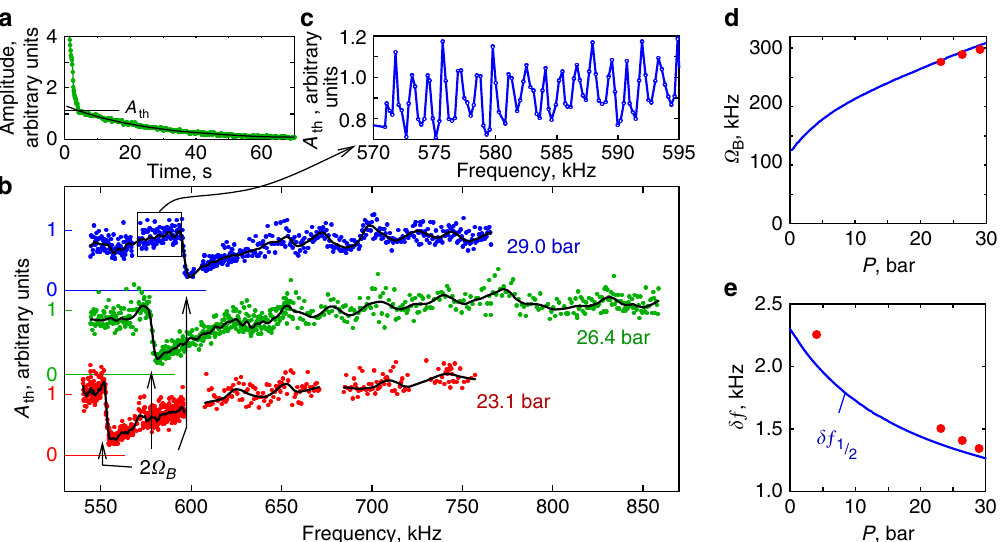
Figure 3 | Measurements of the Suhl instability. ( a ) An example measurement of the NMR signal amplitude during the magnon condensate decay obtained at o L /2 p ¼ 741kHz and P ¼ 26.4 bar. A Suhl instability threshold at the amplitude A th is clearly seen. ( b ) Dependence of the threshold amplitude A th on the frequency of optical magnons o opt E o L (coloured symbols) for three pressures P . Sharp decrease is seen at o opt ¼ 2 O B ( P ), where the decay of an optical magnon to two light Higgs bosons becomes possible. Black lines are smoothed data using running average. Curves for different pressures are shifted in the vertical direction and respective zero levels are marked by horizontal lines. ( c ) Zoom to one measurement in ( b ) shows periodic modulation, which corresponds to resonances of acoustic magnons in the experimental container. ( d ) Pressure dependence of the light Higgs boson mass O B (symbols) from measurements in ( b ). ( e ) Frequency separation of acoustic magnon resonances (symbols) from measurements like in ( c ). Solid lines in ( d , e ) are theoretical values based on known 3 He parameters 28 without